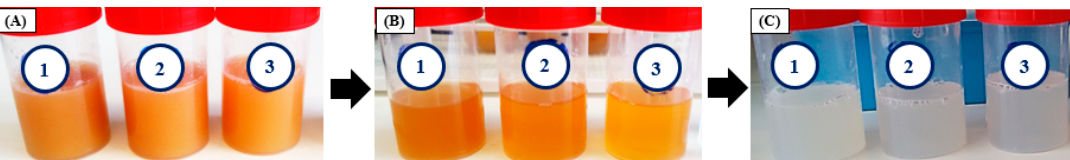
Figure 1. Macroscopic aspect of: ( A ) initial CGC suspensions in the three NaOH/urea solvent systems; ( B ) the CGC solutions obtained after removal of the insoluble fraction by centrifugation; ( C ) the corresponding CGC solutions after dialysis against deionized water. Solvent systems 1, 2 and 3 are represented by the numbers 1, 2 and 3, respectively. Table 1. Solubilized CGC mass, polymer concentration and overall solubilization of the soluble fractions in different NaOH/urea solvent systems.